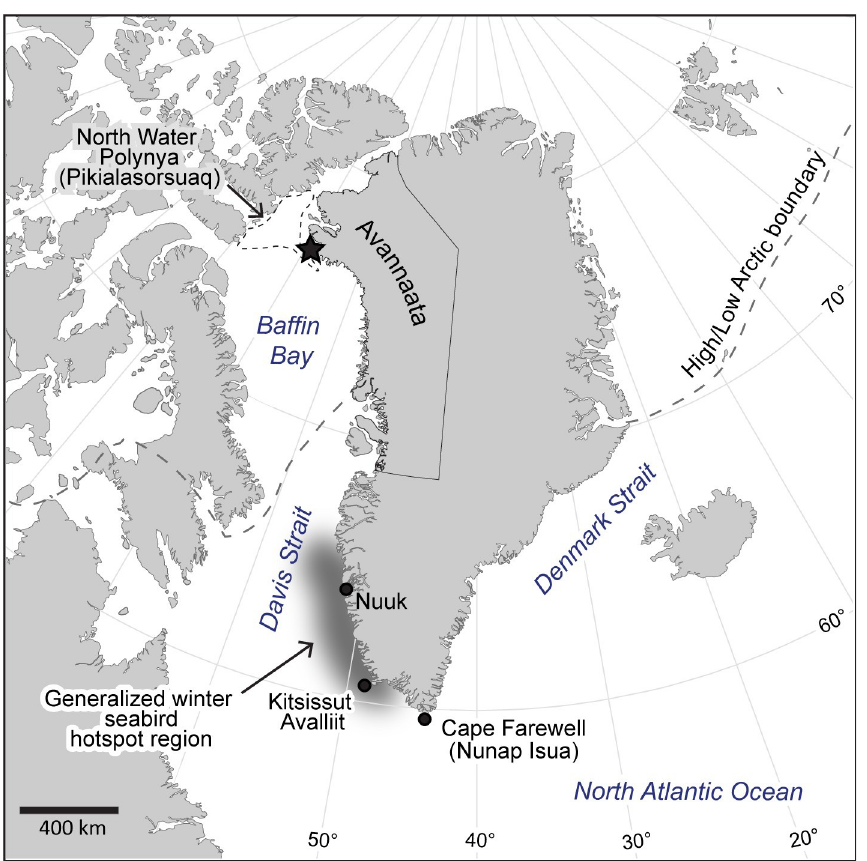
Fig 1. Study area map and geographic place names. Map indicating location of study colony (black star) and place names used throughout the paper. Country boundaries from [28].